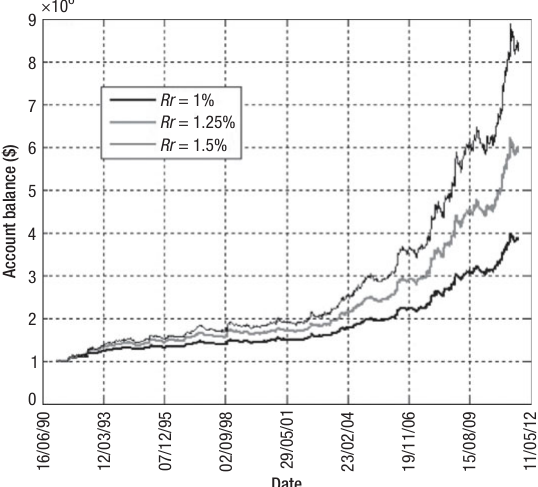
Fig. 4. Research results with different risk